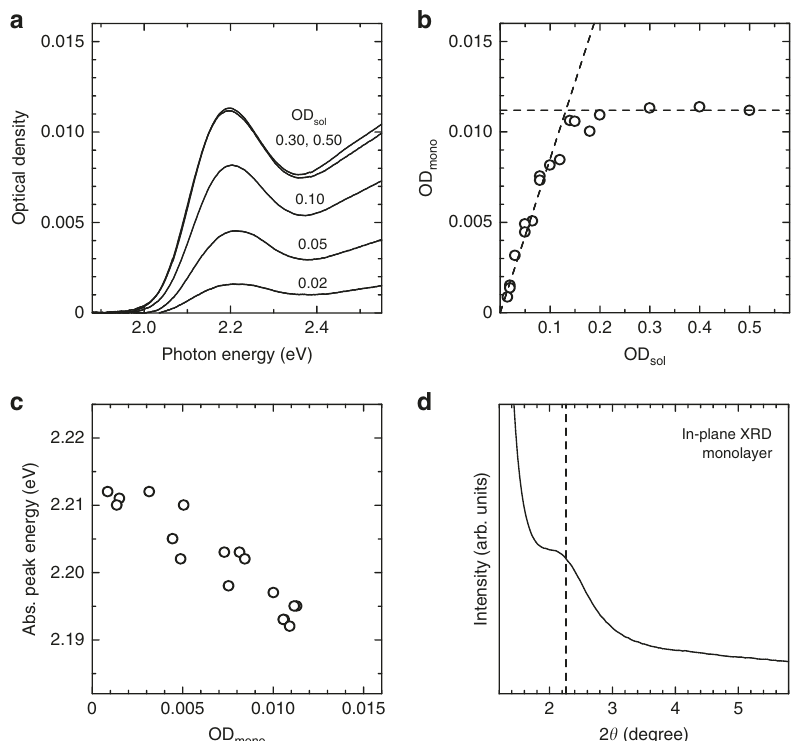
Fig. 2 Absorption properties and X-ray diffraction (XRD) structural analyses of quantum dot monolayers. a Absorption spectra of CdTe quantum dot monolayers fabricated from colloidal quantum dot solutions with different concentrations. b Optical densities (ODs) of the absorption peaks of the monolayers (OD mono ) versus the OD of the absorption peak of the colloidal quantum dot solution (OD sol ). One of the dashed lines is proportional to OD sol , which shows that the OD mono is proportional to OD sol . The other dashed line shows the value at which the OD mono is saturated. c Dependence of the absorption peak energy of the quantum dot monolayers on OD mono . d In-plane XRD pattern of the CdTe quantum dot monolayer with high in-plane quantum dot density ( σ in-plane ), which exhibits 2D quantum resonance. The dashed line shows the peak